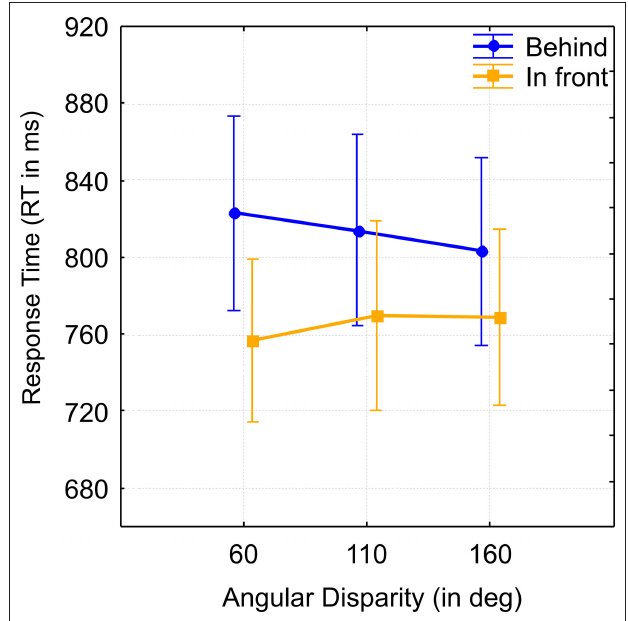
Figure 5 | results experiment 2 in the level 1 analysis. Group mean response times (RT) for “in front” vs. “behind” judgments in Experiment 2 at each angular disparity, which reflects the significant interaction between angular disparity and preposition. Vertical bars denote the standard error of mean. Further explanations in the